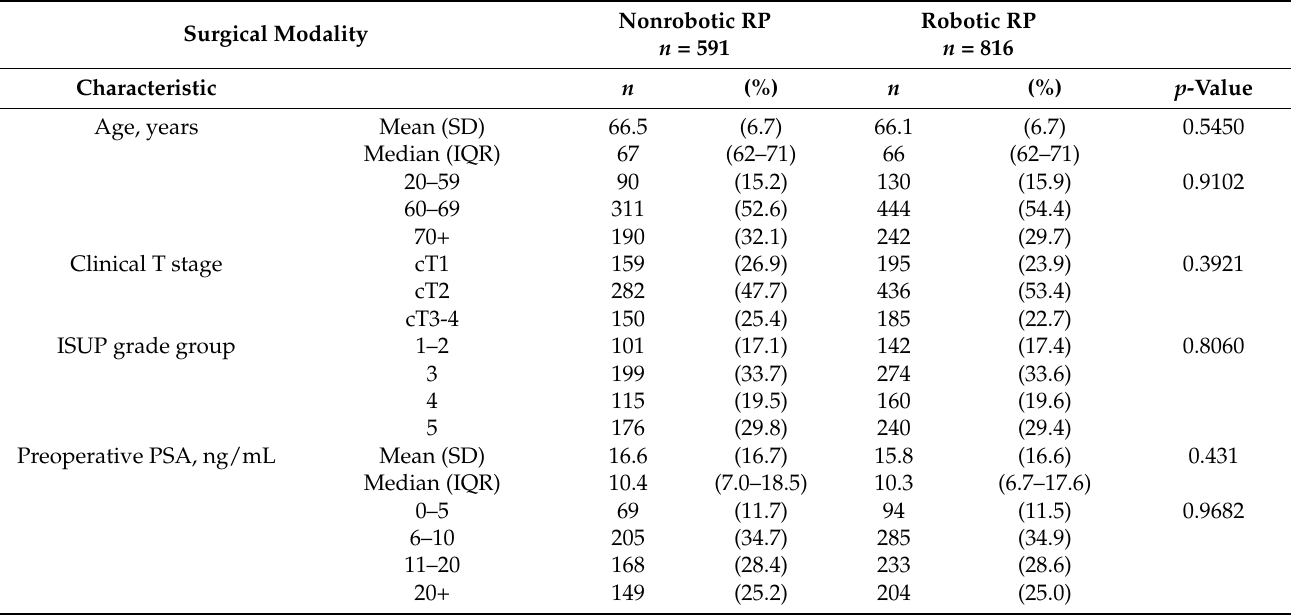
Table 1. Clinicodemographic characteristics of patients with prostate adenocarcinoma stratified by whether they underwent nonrobotic or robotic radical